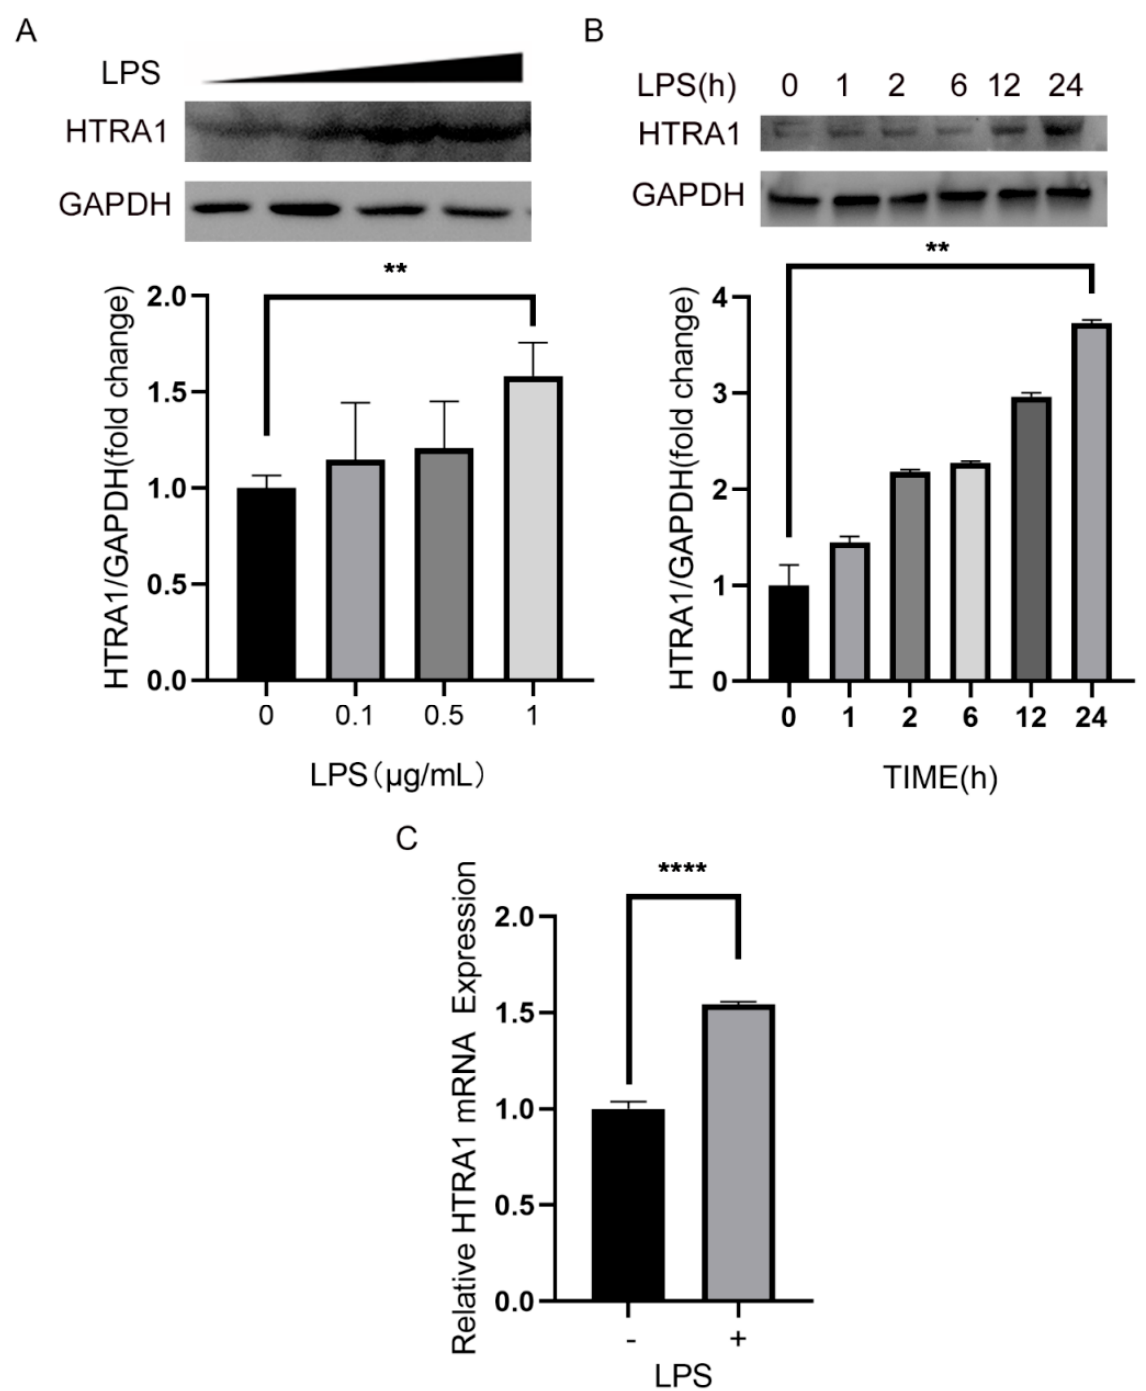
Figure 1. HTRA1 expression in ARPE-19 cell line after LPS stimulation. ( A ) Western blot analysis of HTRA1 expression in ARPE-19 cell line stimulated by different concentrations of LPS for 24 h. ** p < 0.01. ( B ) Western blot analysis of HTRA1 expression in ARPE-19 cell line stimulated by 1 µ g/mL LPS for different time. ** p < 0.01 ( C ) Changes of HTRA1 mRNA after stimulation of 1 µ g/mL LPS for 24 h. **** p < 0.0001.